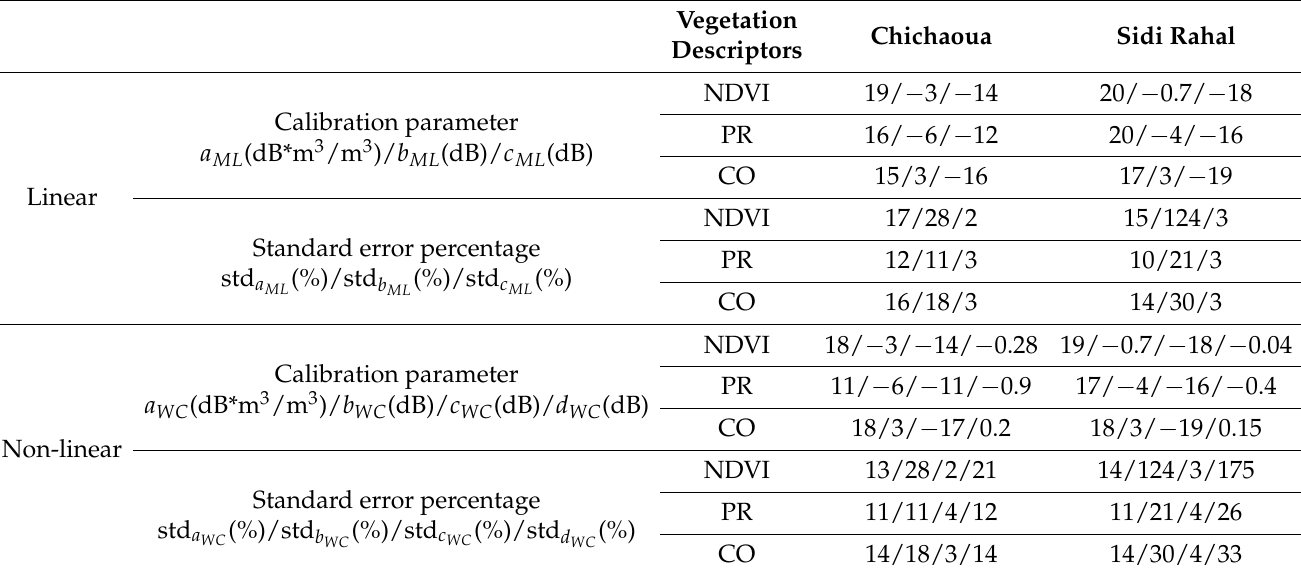
Table 1. Values of the calibration parameters and their standard error for linear and non-linear RTM using NDVI, PR and CO as vegetation descriptor separately for Chichaoua (left) and Sidi Rahal (right) sites where in situ SM data are used for the